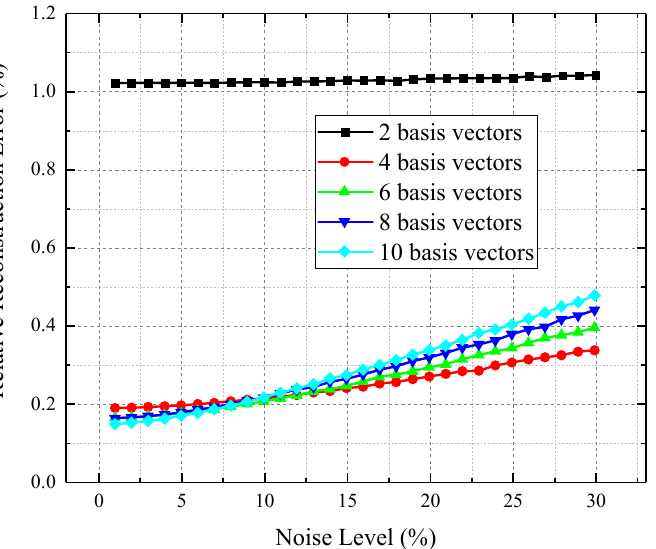
Figure 9. Joint effect of the number of basis vectors and the noise level (%) on the reconstruction error (velocity field).